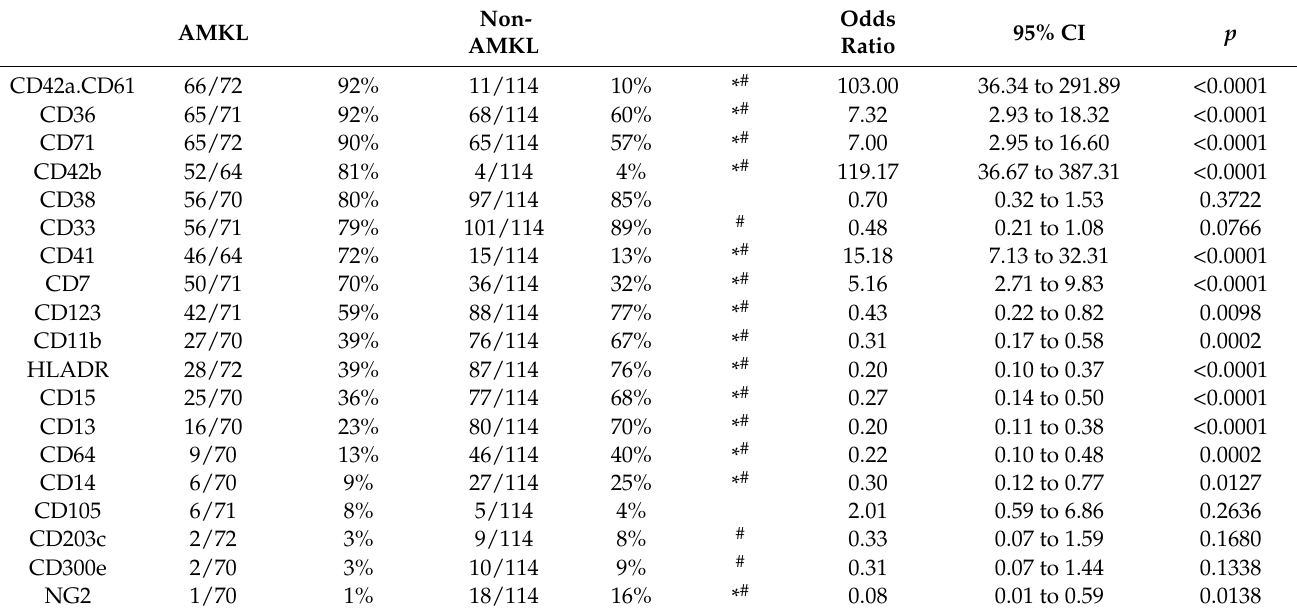
Table 2. Expression of markers in AMKL and non-AMKL patients a